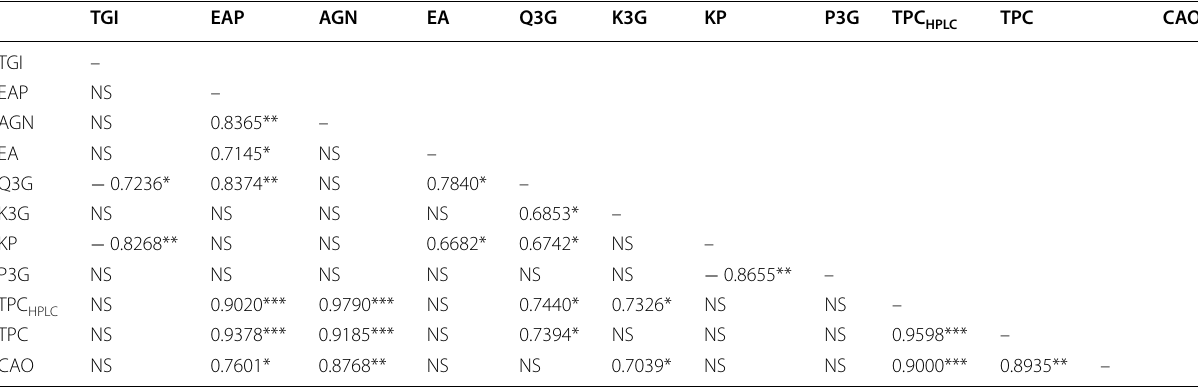
Table 2 Correlations coefficients for different variables